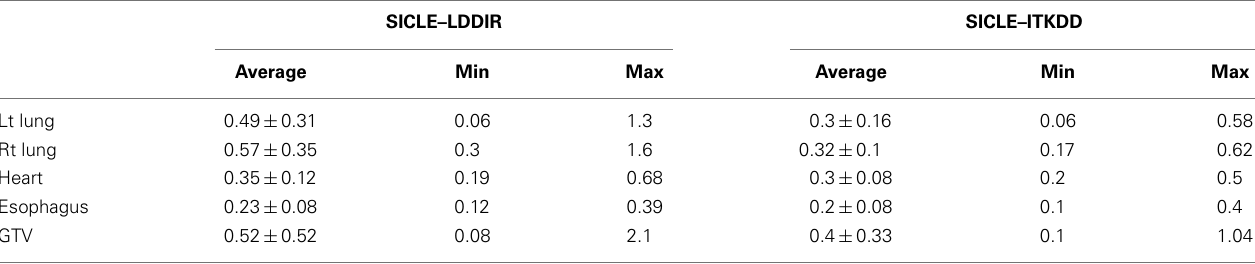
Table 5 | 35% volume boundary of SDVH for 13 patients